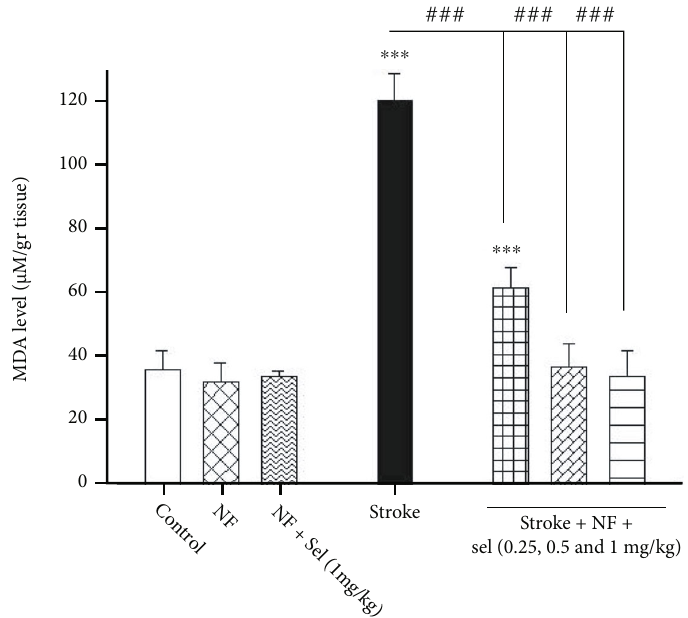
Figure 9: E ff ects of selegiline-NBP nanoformulation on MDA level in the brain. Values are expressed as the mean ± SD and were analyzed using one-way ANOVA followed by Tukey ’ s post hoc test ( n = 3 ). ∗ P < 0 : 05 , ∗∗ P < 0 : 01 , and ∗∗∗ P < 0 : 001 compared with control group. # P < 0 : 05 and ## P < 0 : 01 and ### P < 0 : 001 compared with transient global ischemia rats. “ NF = nanoformulated containing NBP; NF+sel = nanoformulated containing NBP+selegiline. ”